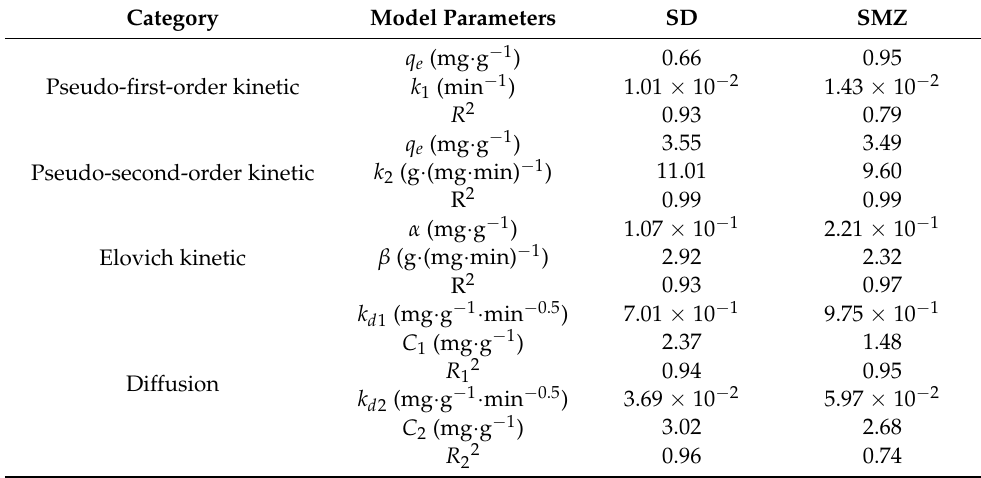
Table 2. Kinetic parameters for the adsorption of sulfonamide by